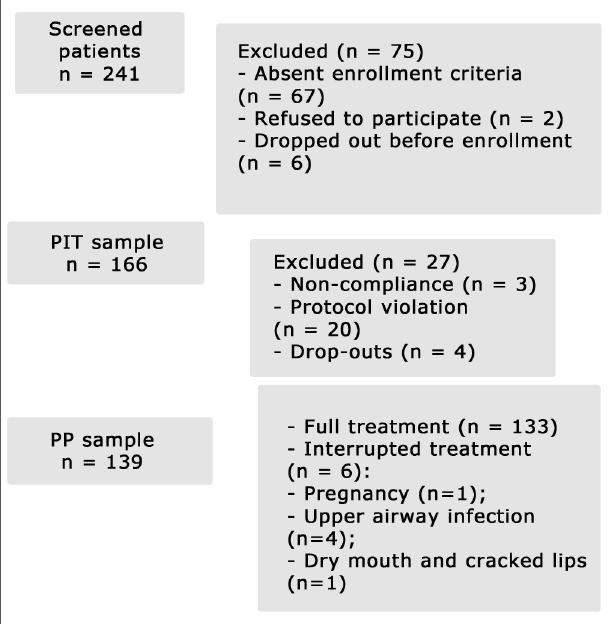
Figure 1. Flowchart - patient enrollment and